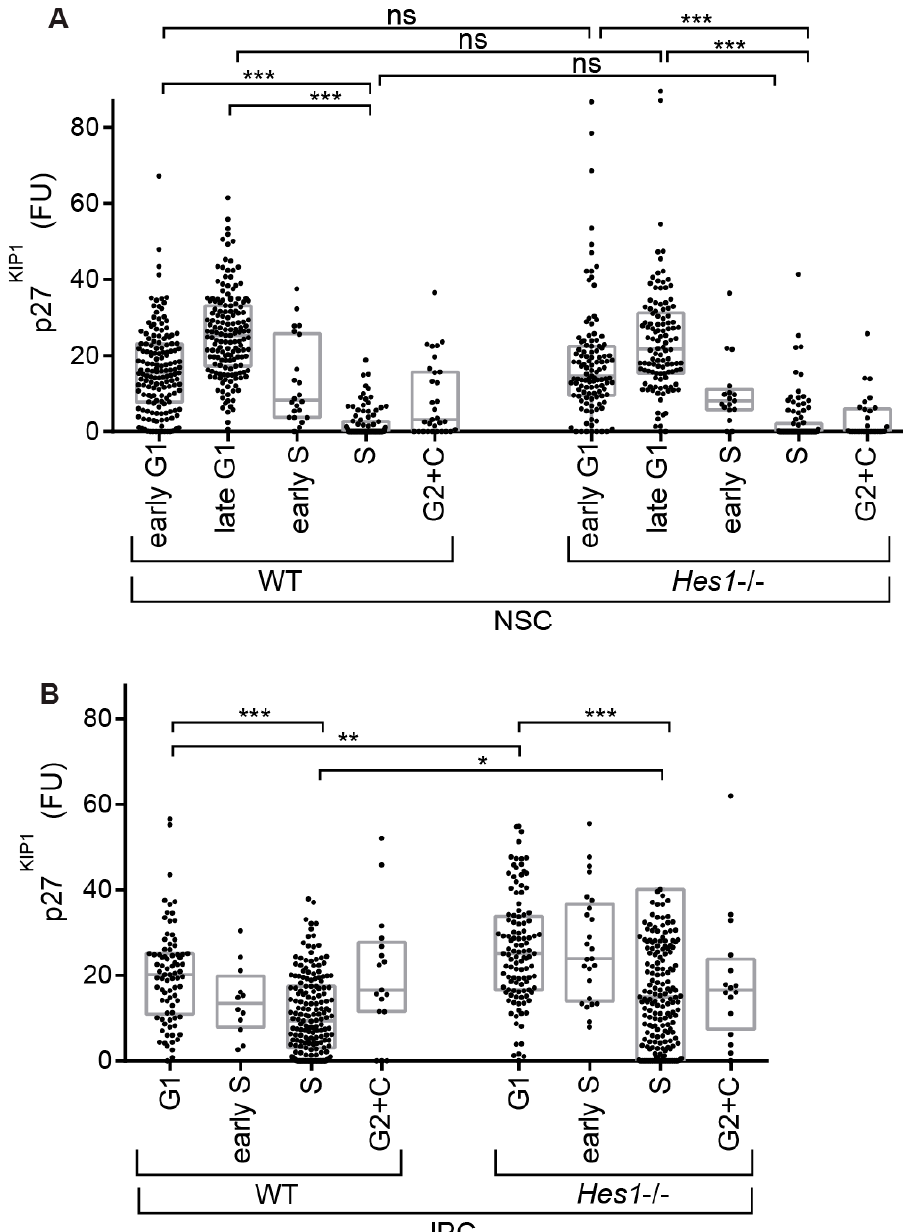
Figure 6. Box plots comparing p27 KIP1 levels between WT and Hes1- / -. ( A ) NSCs (n = 159, 159, 22, 98, 31, 115, 114, 17, 95, 29); ( B ) IPCs (n = 82, 12, 181, 17, 113, 25, 175, 16). These data show p27 KIP1 levels are upregulated in Hes1- / - IPCs, but not in NSCs. FU–average intensity in fluorescence units. Krustal-Wallis tests with Dunn ′ s multiple comparisons. ns (not significant), * ( p ≤ 0.05), ** ( p ≤ 0.01), *** ( p ≤ 0.001).